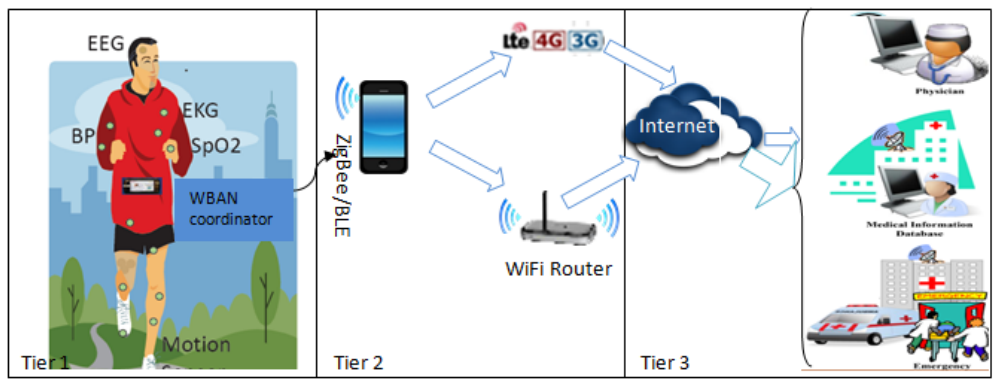
Figure 1. Three-tier architecture of